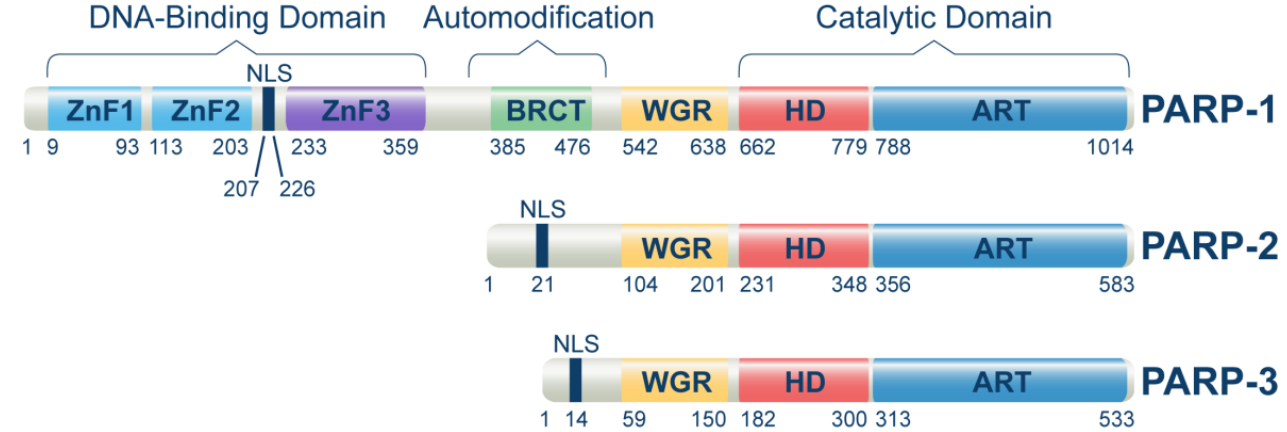
Figure 1. Domain structure of human PARP-1, PARP-2, and PARP-3 proteins. The domain locations within the full-length proteins were extracted from the uniport database by using the following entries for PARP-1 (P09874), PARP-2 (Q9UGN5), and PARP-3 (Q9Y6F1). Main protein domains involved in DNA-binding, auto-modification, and catalytic functions are indicated. ZnFI: zinc finger I